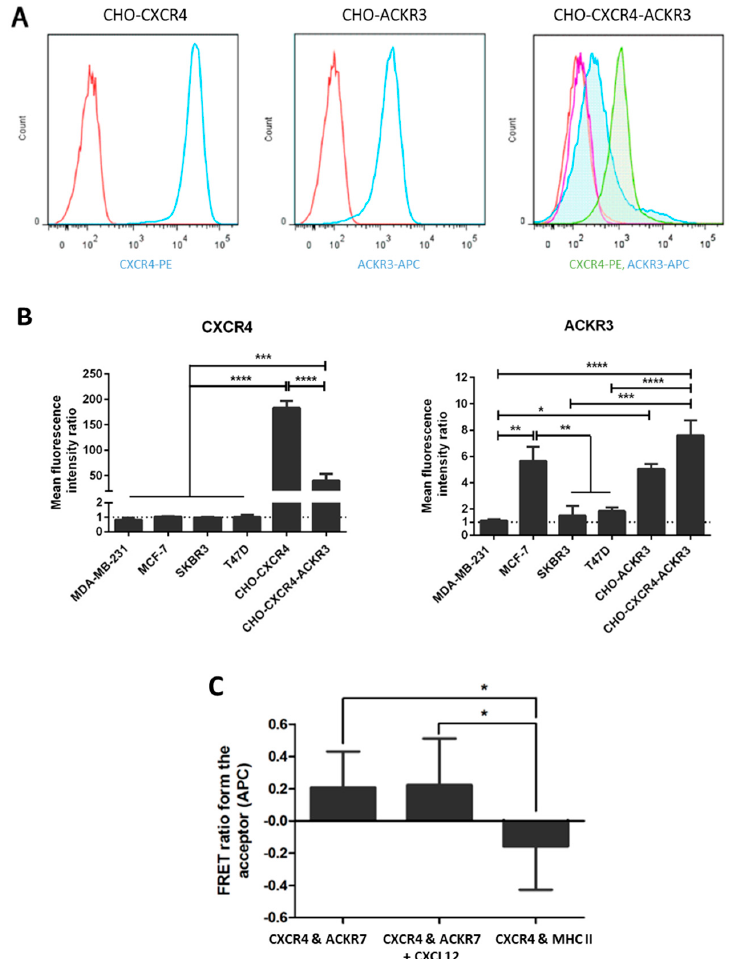
Figure 2. Expression of CXCR4 and/or ACKR3 in transfected CHO cells. CHO cells were transfected with pcDNA3.1/Zeo-CXCR4 and/or pcDNA3-ACKR3 using Effectene and selected with antibiotics. ( A ) Histograms showing CXCR4 or ACKR3 expression in the final selected colonies. Cells were stained with PE or APC-conjugated antibodies and expression was assessed using flow cytometry (Red = Isotype, blue = antibody) on CHO-CXCR4 ( left ) and CHO-ACKR3 ( middle ); and red = isotype for CXCR4, purple = isotype for ACKR3, green = CXCR4, blue = ACKR3 on CHO-CXCR4-ACKR3 ( right ) cells. ( B ) Mean fluorescence levels of the transfected CHO cells were determined and compared to several breast cancer cell lines to assess CXCR4 ( left ) and ACKR3 ( right ) receptor levels. Data represents the mean ± SEM of three independent experiments and statistical significance was calculated using a one way ANOVA (* p < 0.05). ( C ) Formation of heterodimers was assessed using fluorescence resonance energy transfer (FRET) and quantified through the FRET ratio from APC (the acceptor fluorochrome). Data represents the mean ± SEM of three independent experiments and statistical significance was calculated using a one way ANOVA (* p < 0.05, ** p < 0.01, *** p < 0.001, **** p < 0.0001).